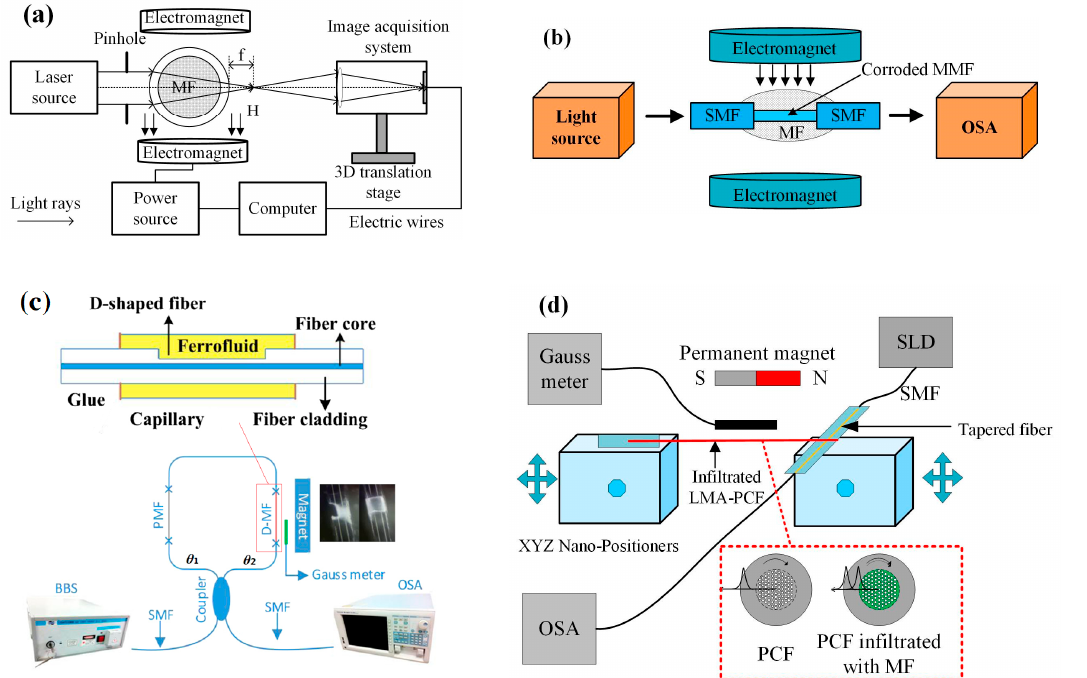
Figure 10. ( a ) Magnetic field sensing system based on a capillary tube filled with MF [71], ( b ) schematic of sensing system based on MF and a singlemode-multimode-singlemode (SMS) fiber structure [72], ( c ) sensor head and sensing system based on an optical fiber Sagnac interference effect [73], ( d ) sensing system configuration of photonic crystal fibers (PCF) infiltrated with MF [75]; permission conveyed through the Copyright Clearance Center, Inc.